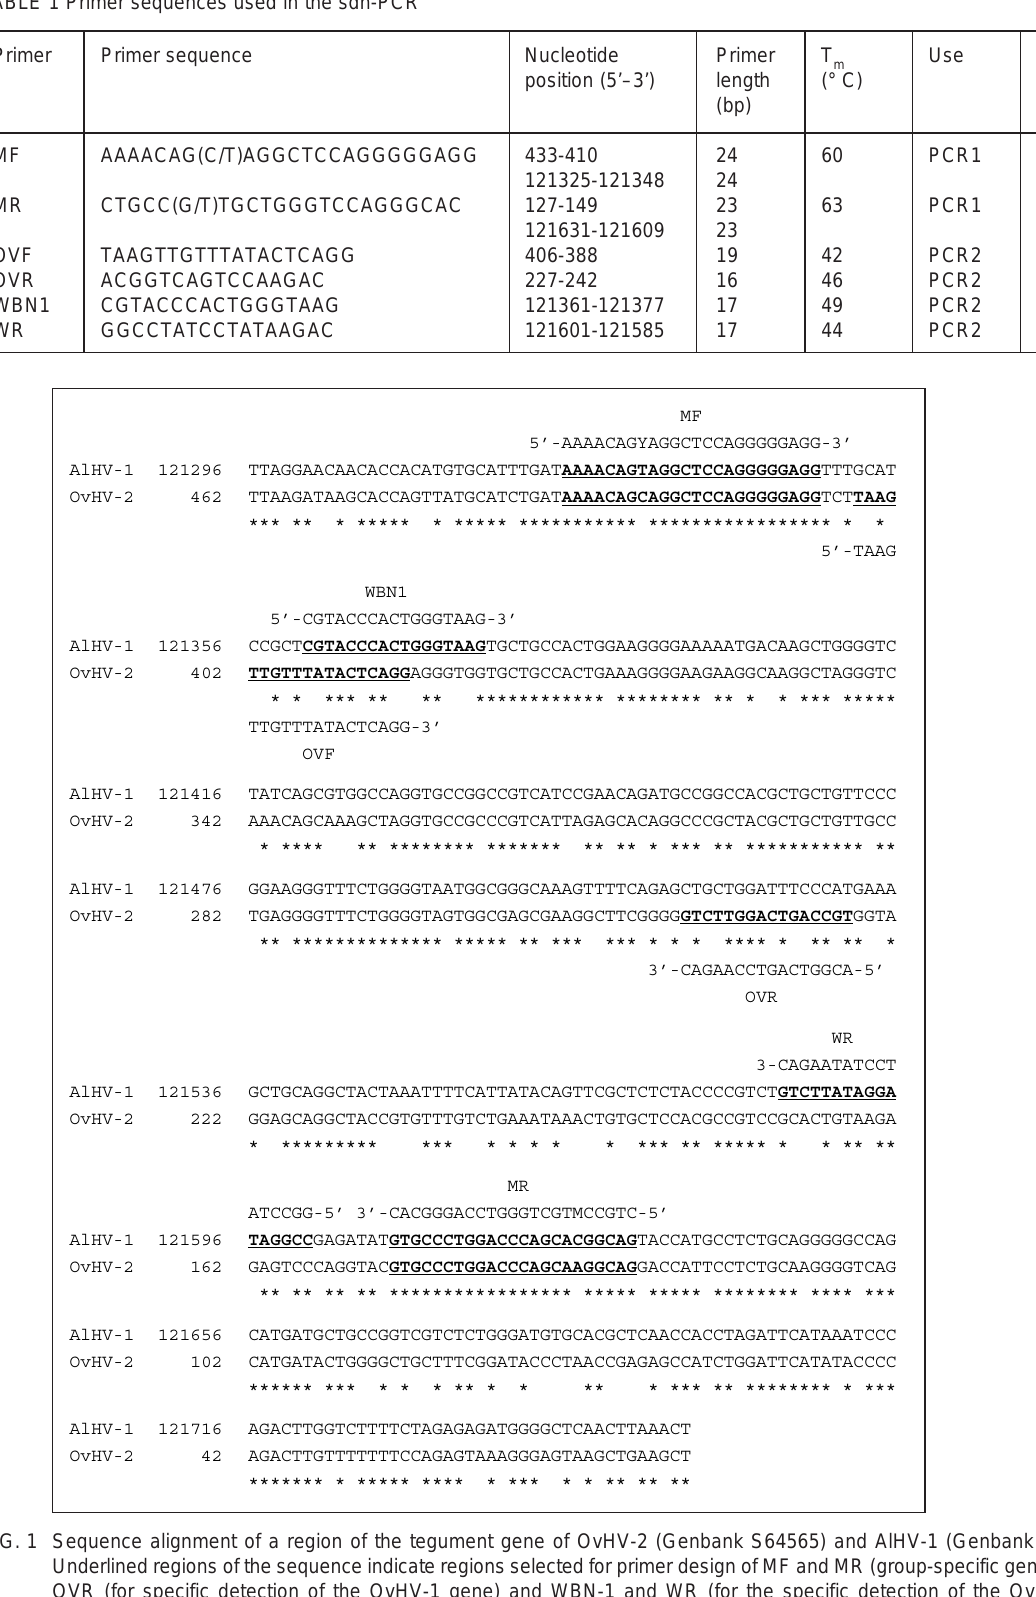
TABLE 1 Primer sequences used in the sdn-PCR Primer